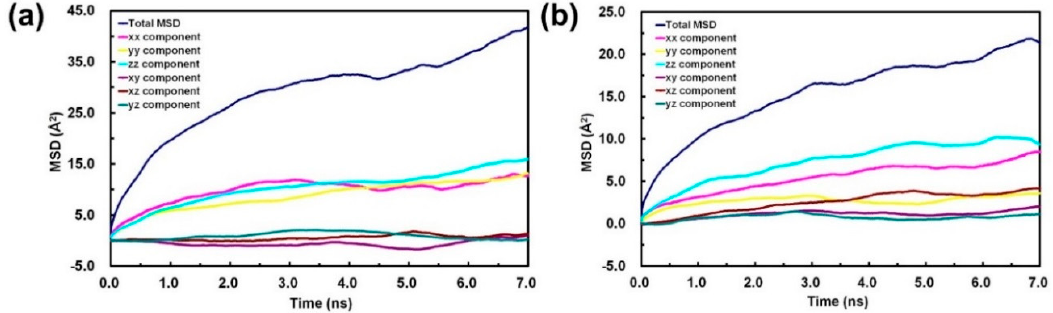
Figure 6. Mean-square displacement (MSD) of CO 2 in ( a ) EB-PANI and ( b ) Na-SPANI (III) as a function of simulation time.